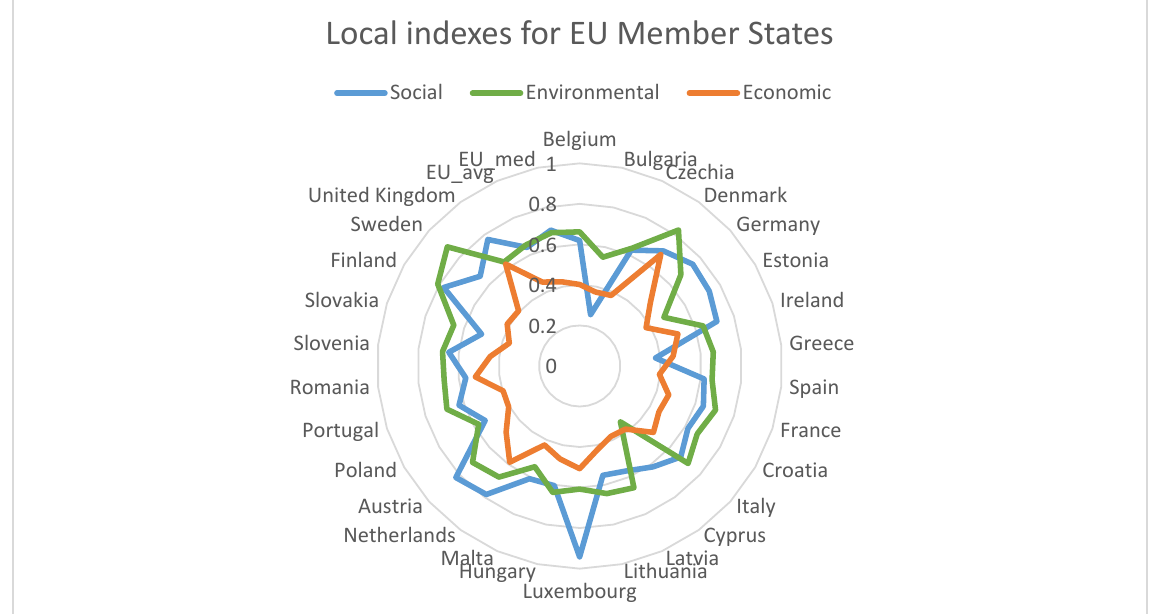
Figure 5. Social, economic and environmental dimension indexes in 2017 for the EU-28 Member States. The SEDAI for the EU Member States takes values from 0.394 to 0.737. The difference between the best and worst-performing Member States is 0.343. The first place belongs to Denmark. The Member States on the podium are also Luxembourg and Netherlands. The worst-performing countries, with SEDAI values below 0.5, are Cyprus and Bulgaria. Fifteen of the EU-28 Members States have SEDAI values below the EU average. The EU-28 average of SEDAI is 0.64 and the median is 0.685. This is due to significant asym- metry of some economic dimension indicators (see Table 2). In particular, this applies to EC16-EC18 indicators describing strategic fuel stocks and, to a lesser extent, EC1 indicator describing the structure of the energy market (i.e., number of electricity generating com- panies). After removing the mentioned indicators, the mean and median of the economic index coincide in the ranking. The same situation occurs with some environmental dimen- sion indicators: ENV7 describing sulfur oxides intensity of energy production, ENV4 de- scribing air pollution intensity of energy production, and ENV13, which is share of re- newables in gross final energy consumption, with the coefficient of skewness of each men- tioned indicator close to 5. A significant part of indicators in the environmental dimension is characterized by high values of coefficient of skewness, on the 1.5–3 level. Comparing the SEDAI values for subsequent countries in the ranking, we can see slight differences in the order of thousandths of parts. Only at the top and the bottom of the ranking the differences between neighboring countries are around 0.05. The ranking is flattened. For the most part, the ranking was determined by the min- imal differences in SEDAI values between the Member States. This seems to be a positive hint, which proves a similar level of sustainable energy development in a certain group of the Member States. Table 6. Social, economic and environmental dimension indexes, weighted indexes and SEDAI in 2017 for the EU-28 Member States. EU Member States